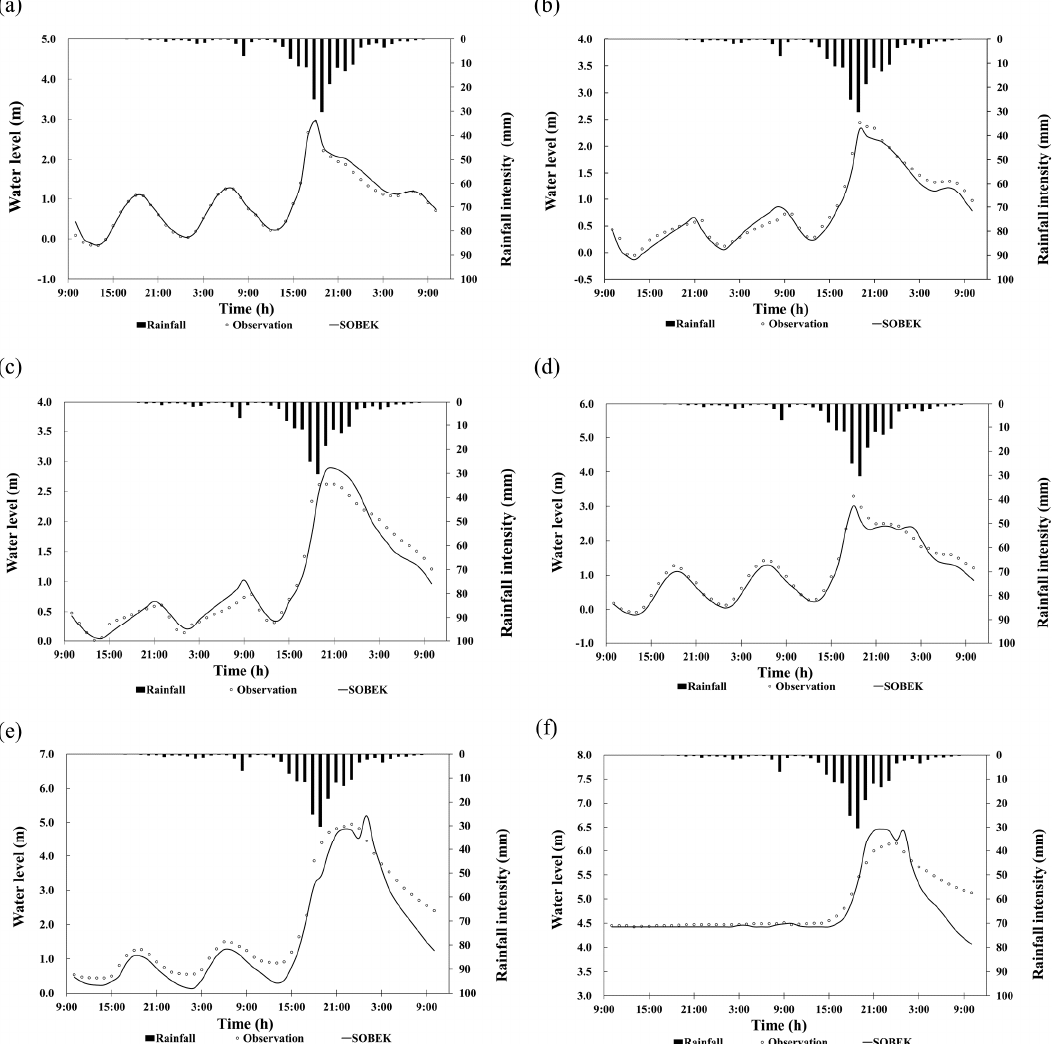
Figure 5. Comparison of observed water levels with simulated ones by SOBEK model for Typhoon Dujuan (from 27 September 2015 9:00 am to 28 September 2015 9:00 am) at ( a ) Gamalan, ( b ) Sijie, ( c ) Dongjin, ( d ) Zhuangwei, ( e ) Yixing, and ( f ) Ximen.